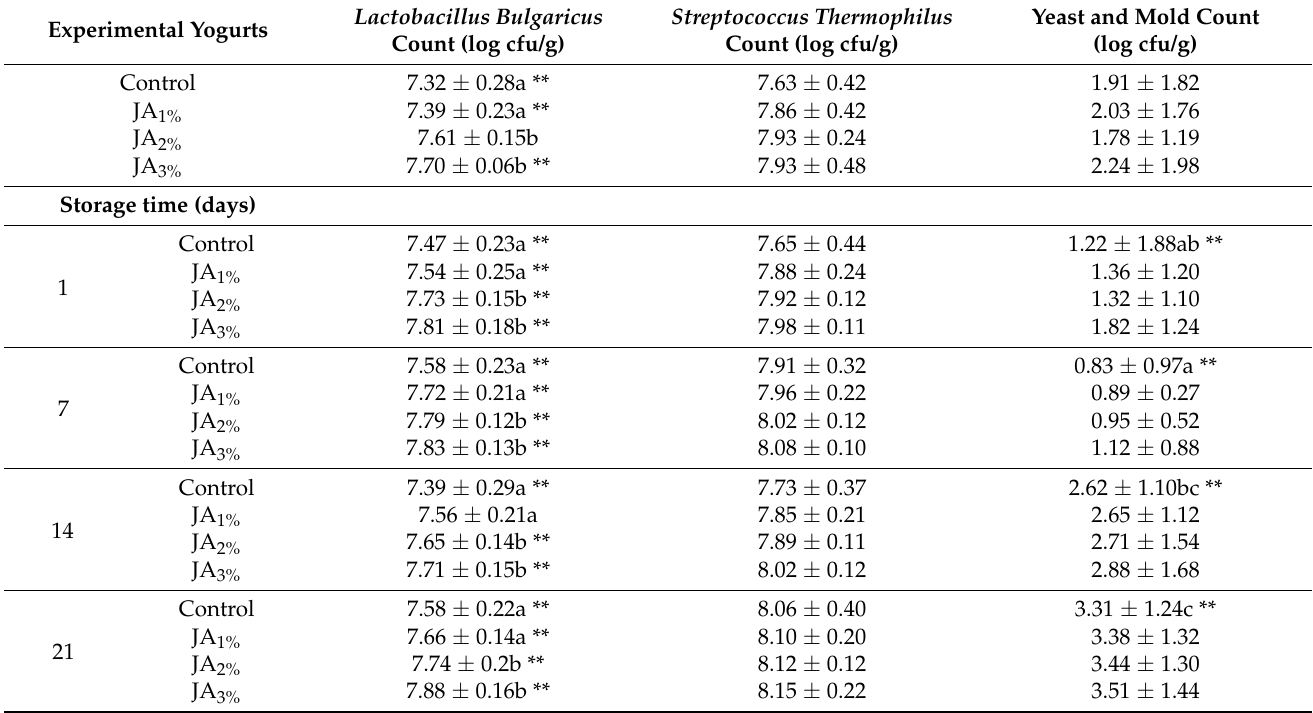
Table 2. The effect of JA ratios and storage periods on physicochemical properties of the experimental yogurts (mean ±